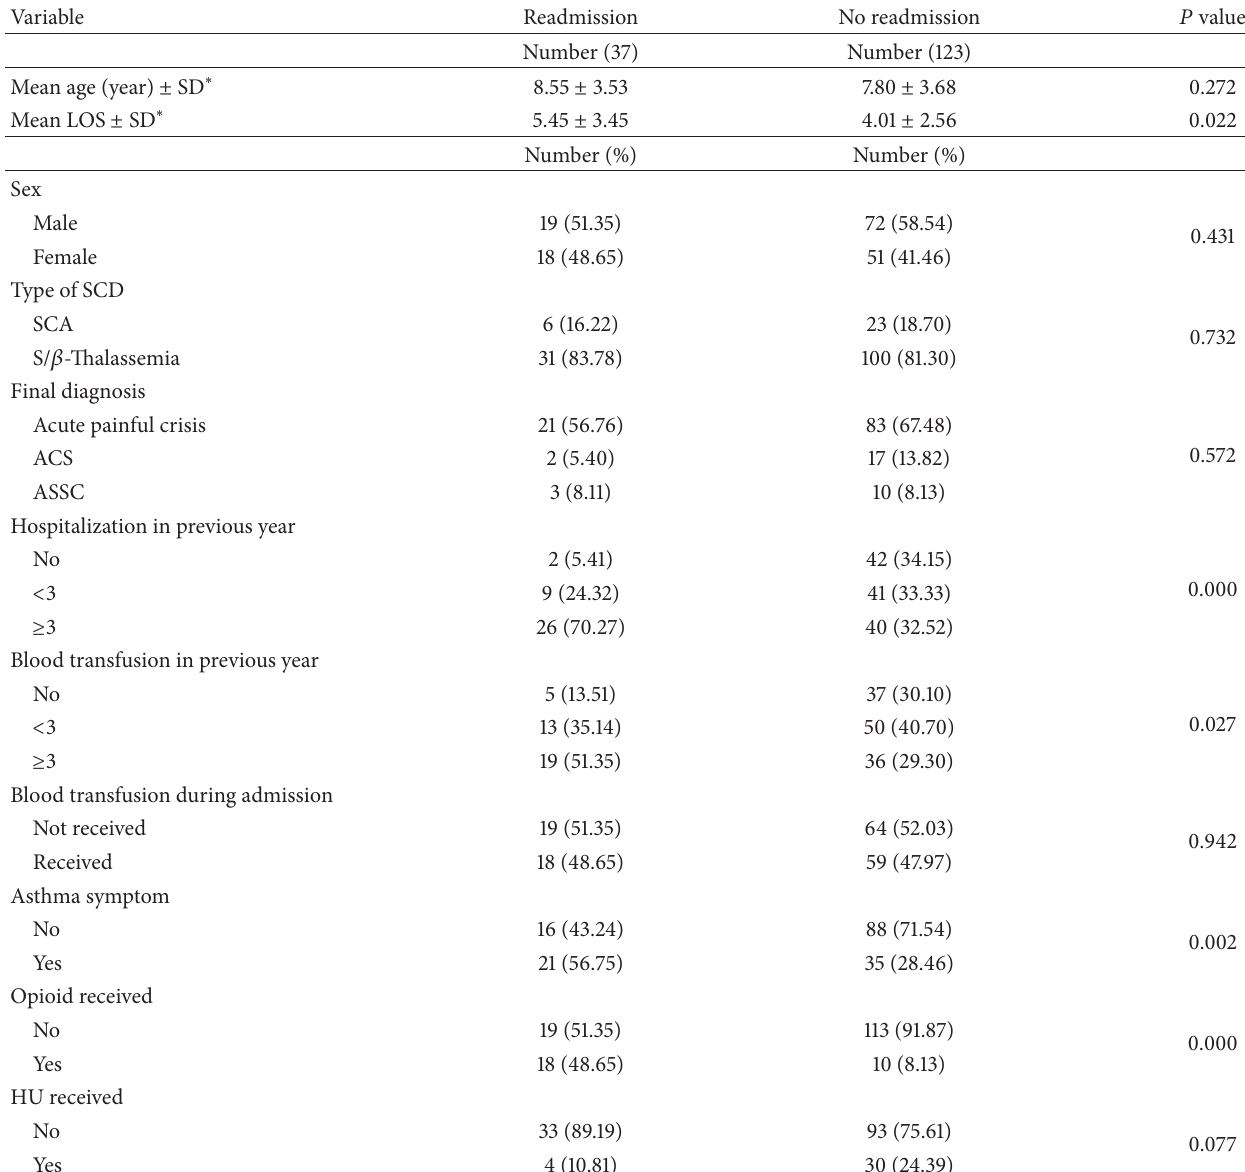
Table 5: Readmission among hospitalized patients with